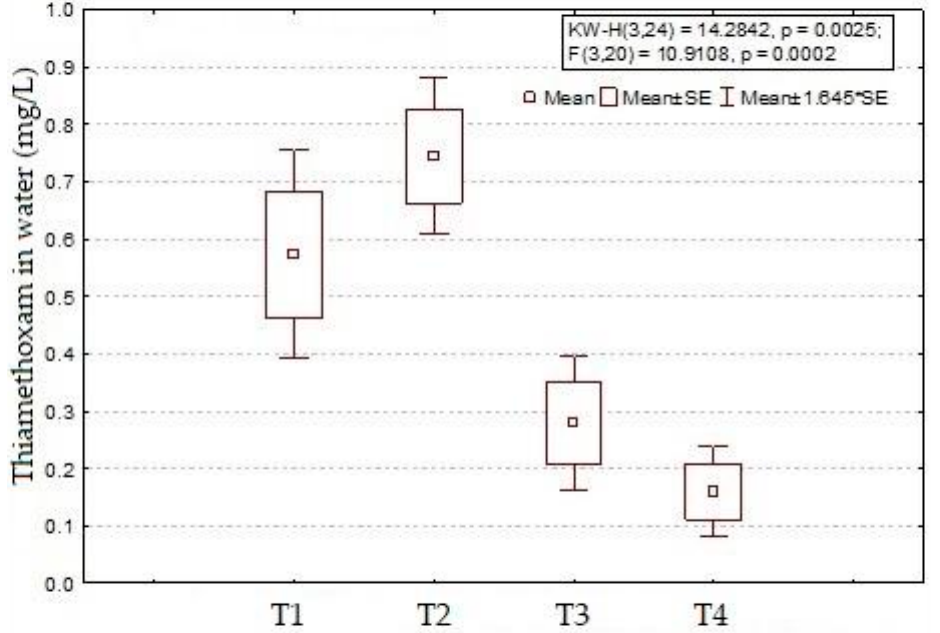
Figure 5. Concentration of thiamethoxam in irrigation water (mg/L). Abbreviations: T1 = Watermelon cultivation; T2 = Soil preparation for papaya; T3 = Stage of papaya transplant; T4 = Papaya in production.